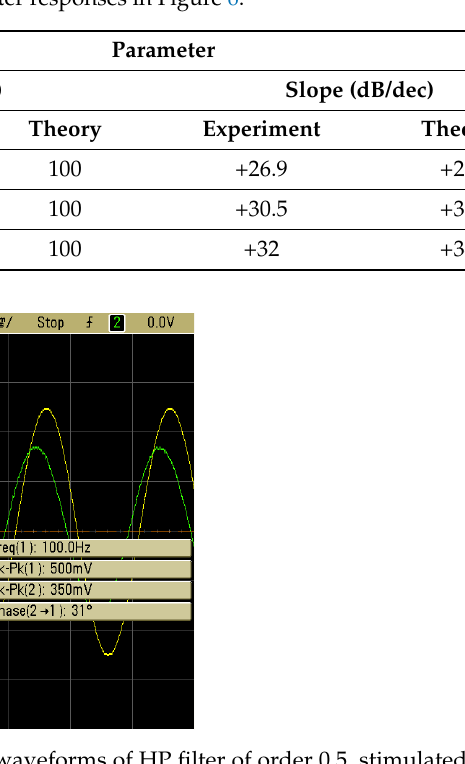
Table 7. Frequency characteristics of HP filter responses in Figure 6.